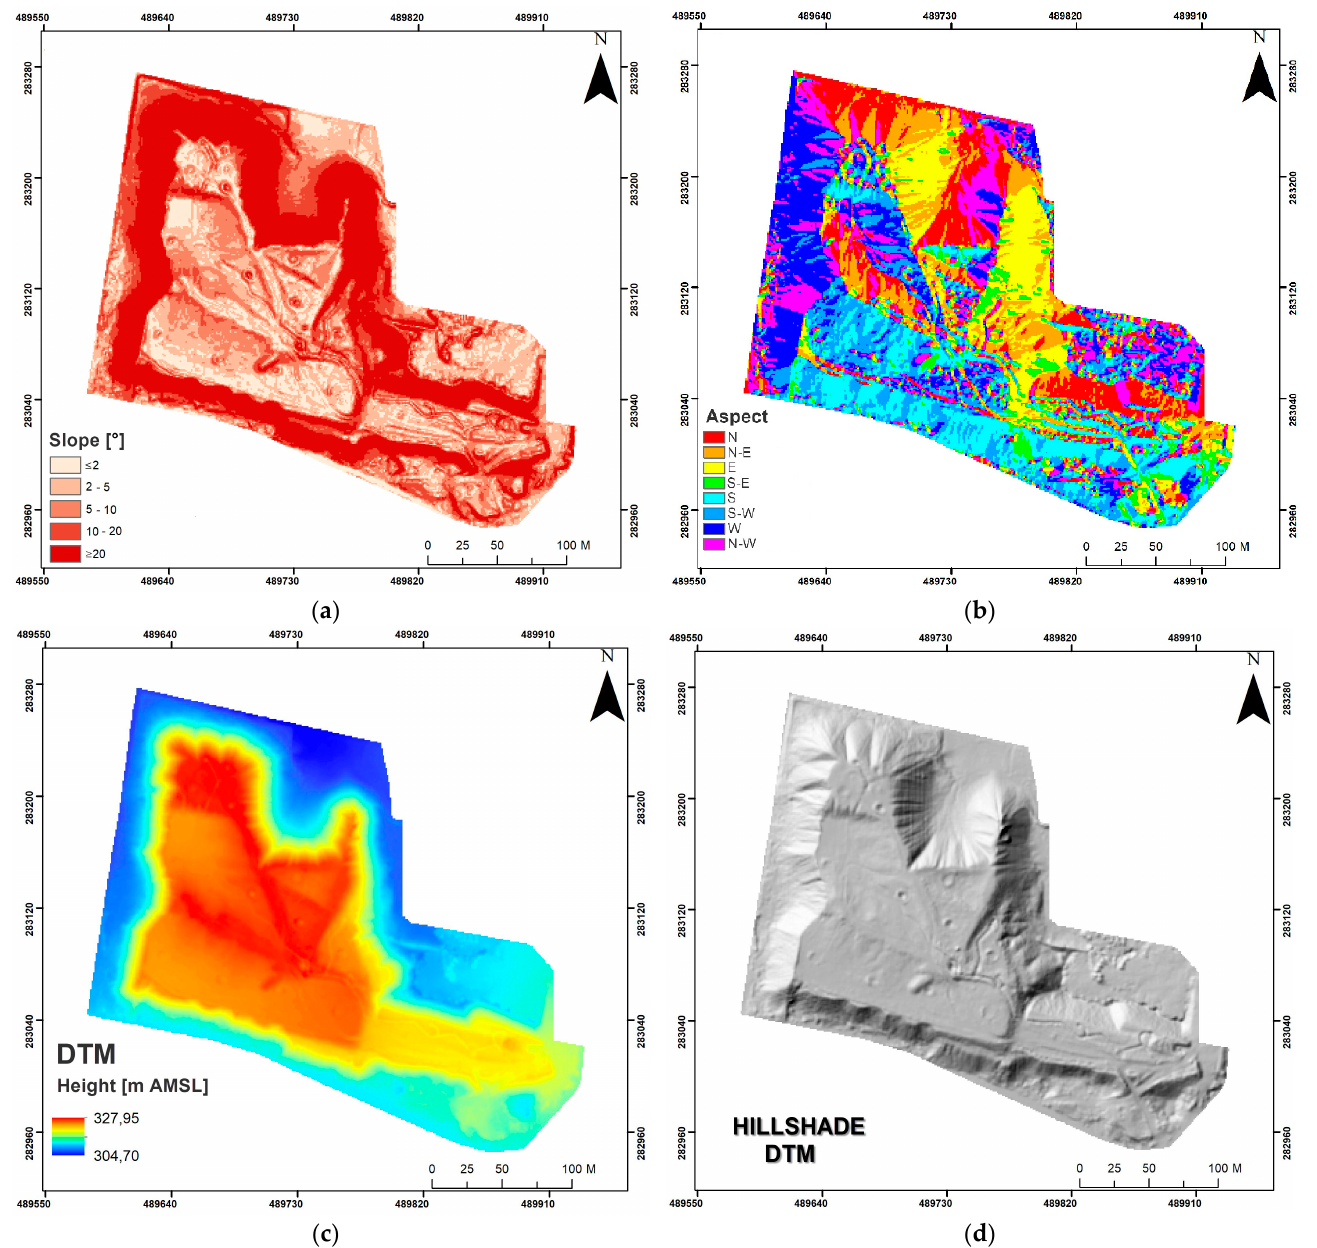
Figure 3. The analyzed area: ( a ) slopes, and ( b ) aspects; ( c ) height in meters AMSL; ( d ) hillshade in greyscale